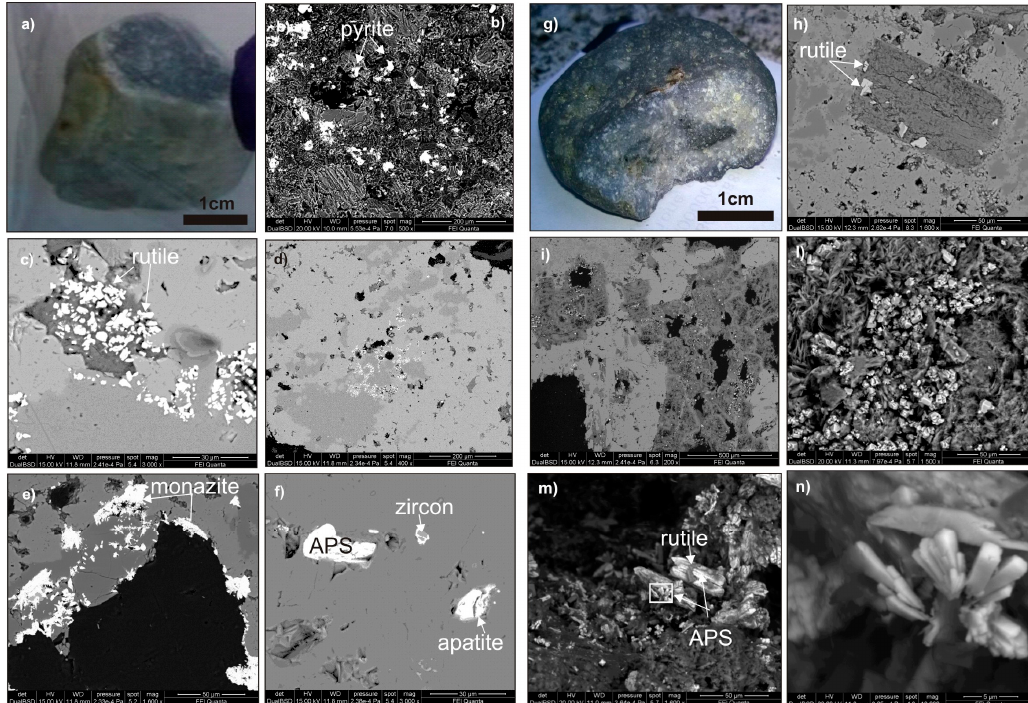
Figure 5. Hand specimen ( a ) and back-scattered-electron images (BSE) images ( b – f ) of ST2BNR2B quartz-K-feldspar altered rhyolite. Authigenic K-feldspar and quartz with disseminated pyrite ( b – d ); rutile crystals ( c ); cluster of monazite crystals associated with rutile grains ( e ); apatite, zircon, and Aluminum-Phosphate-Sulfate (APS) phases in authigenic K-feldspar ( f ). Hand specimen ( g ) and BSE images ( i – n ) of ST2BNR2D quartz-K-feldspar altered rhyolite. Mafic crystal replaced by phyllosilicates and rutile grains ( h ); partially destroyed primary K-feldspar with formation of hydrothermal phyllosilicates and hydrothermal rutile and pyrite ( i , l ); rutile crystals and APS phases ( m ); detail of APS crystals ( n ).